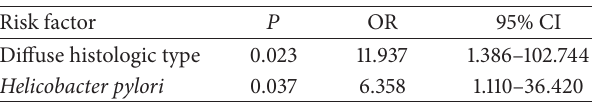
Table 5: Independent risk factors for gastric cancer related to patients younger than 50 after multivariate logistic regression analysis.